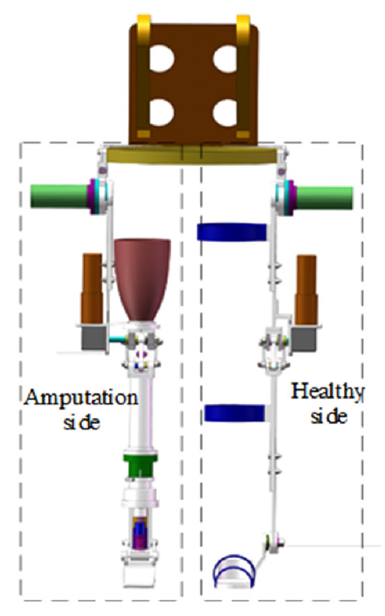
Figure 1. Asymmetric lower limb exoskeleton.